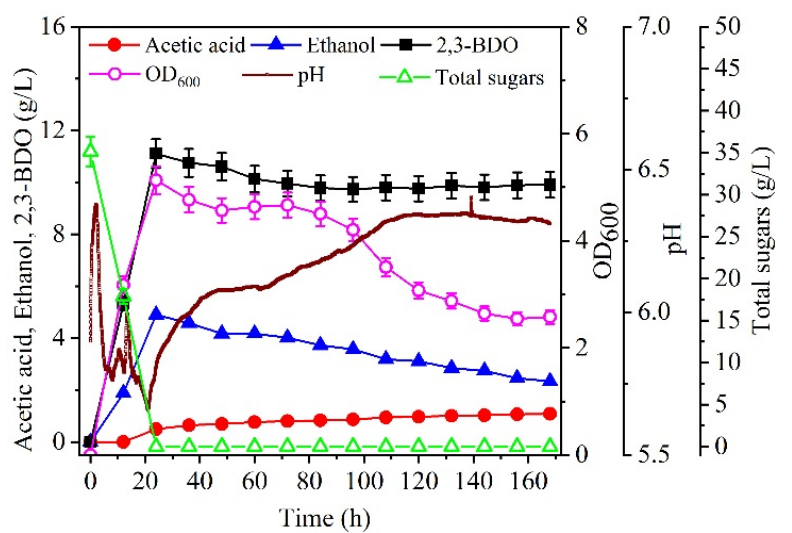
Figure 3. Effect of batch culture on 2,3-BDO production. The cultures were carried out in a 2.7 L bioreaction. Data are given as the mean ± SD, n = 2.